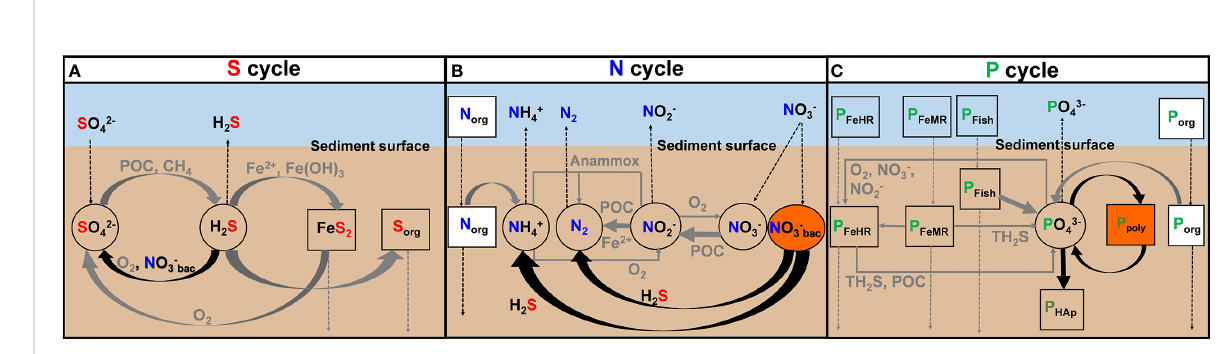
FIGURE 3 Schematic diagram of key biogeochemical processes of (A) S, (B) N, and (C) P cycles in Namibian mud belt sediments considered in the model, including pathways of biological NO − 3 (NO − 3 bac ) reduction by giant sulfur bacteria. The thick black arrows highlight the important reactions related to giant sulfur